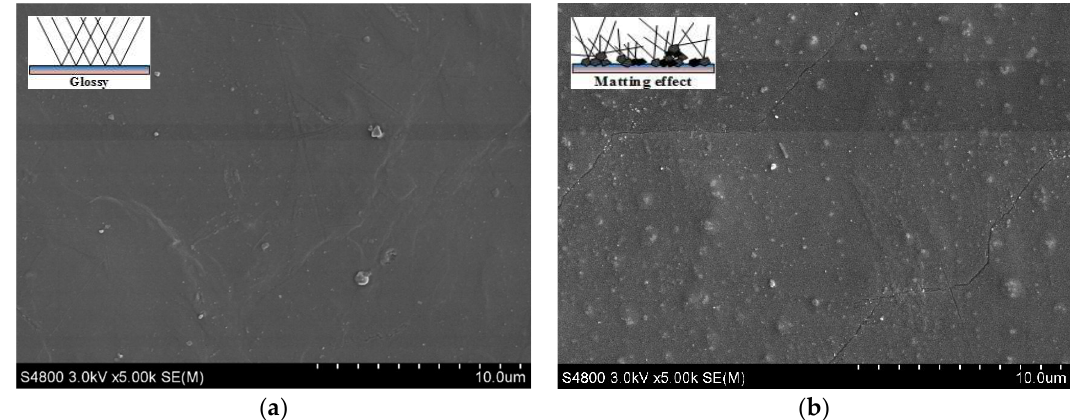
Figure 6. SEM micrographs of coating films with the addition of ATH. ( a ) Formulation H-0.028; ( b ) Formulation H-0.75.